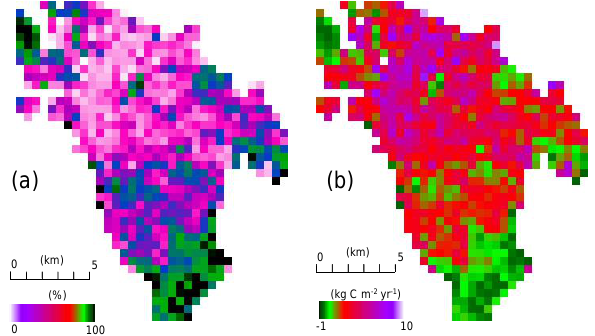
Figure 10. Spatial distributions of (a) the green fraction and (b) the upscaled net CO 2 flux in Sakai City. The green fraction was calcu- lated at a 500m spatial resolution based on an inventory of green